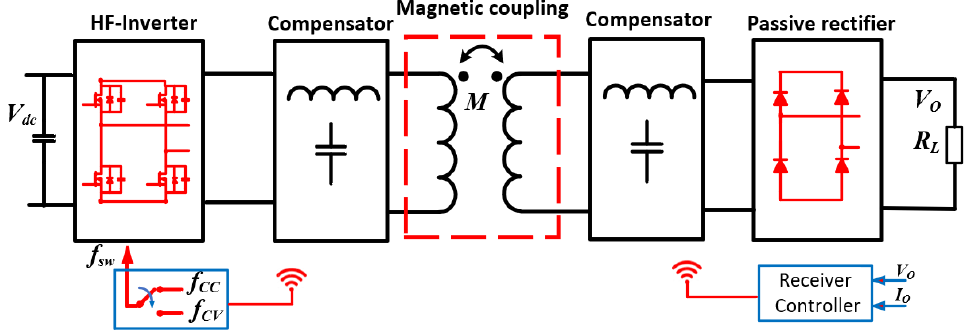
Figure 18. PE structure of switchable dual-frequency control.